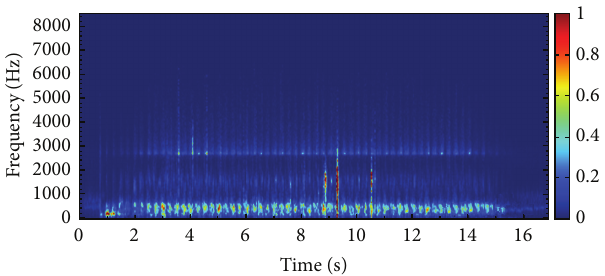
Figure 30: Hilbert energy spectrum of effective microseism signals in working condition 29.